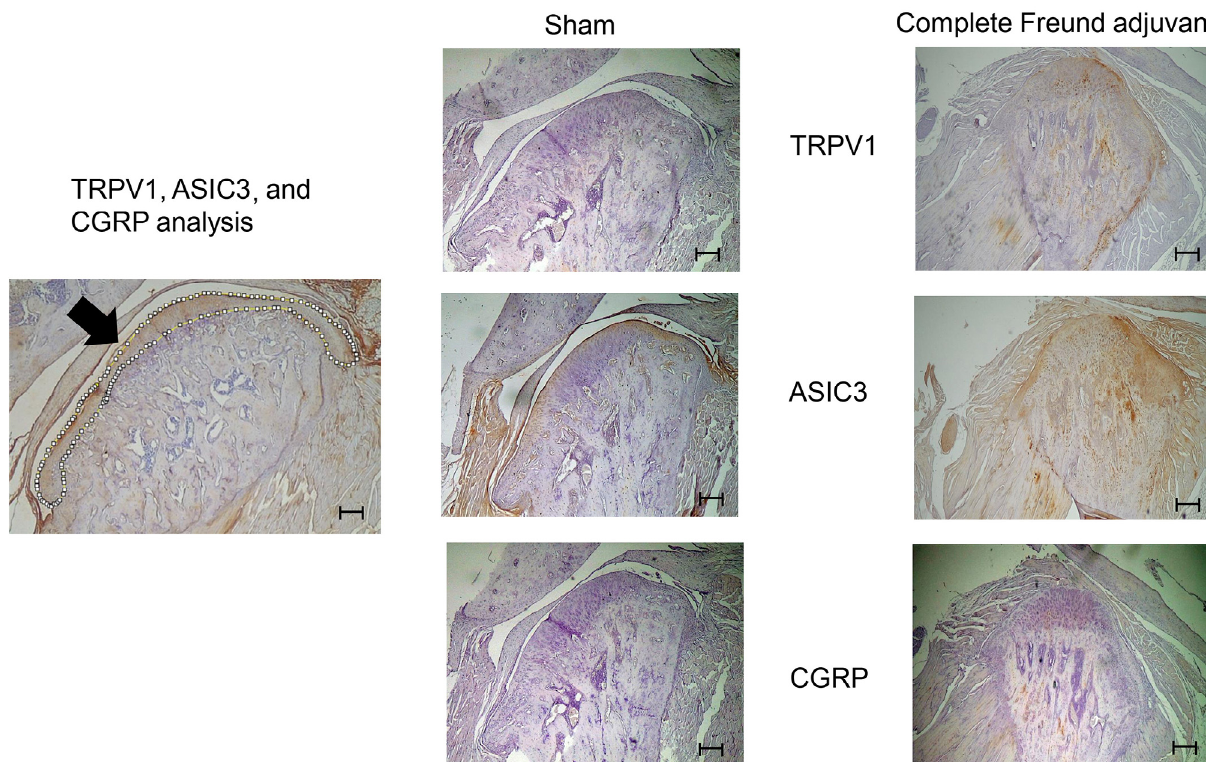
Figure 1- Transient receptor potential vanilloid 1 (TRPV1), acid-sensing ion channel subunit 3 (ASIC3), and calcitonin gene-related peptide (CGRP) in the sham and complete Freund’s adjuvant (CFA) groups, with a 200 µm scale bar. The small white circles pointed by the arrow on the left figure indicate the condylar head of the temporomandibular joint (TMJ), used in the analysis of all experiments